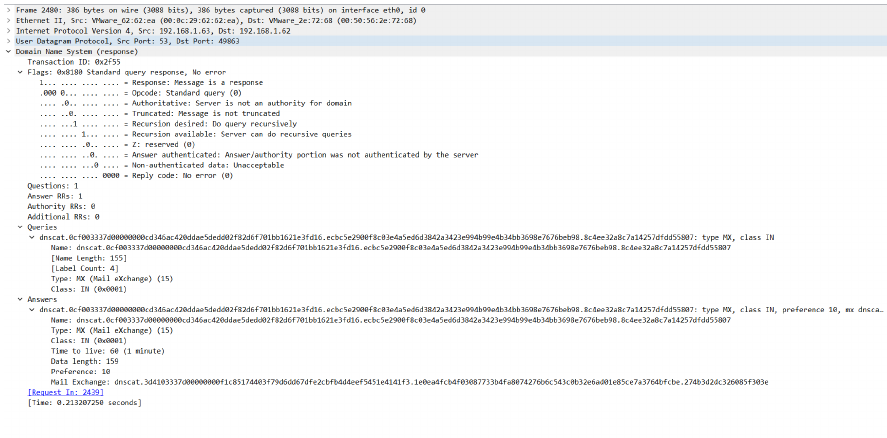
Figure A1. Sample packet generated from Dnscat2 tunneling